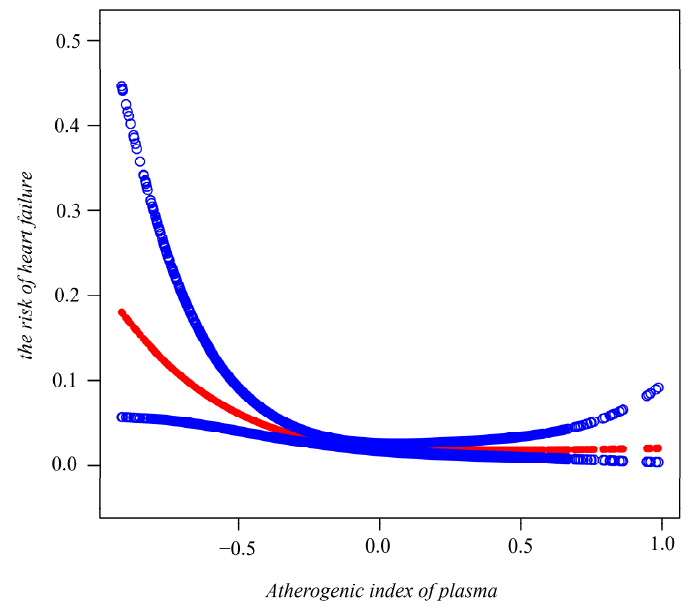
Figure 2. Association between the atherogenic index of plasma and incident heart failure using smooth curve fitting analysis. Adjusted for gender, age, BMI, education level, smoke, coronary heart disease, heart attack, angina, stroke, MetS, diabetes, eGFR, hypertension, glucose, HbA1c, ALT, albumin, globulin, creatinine, blood urea nitrogen, HDL cholesterol, hs-CRP, statins use, diabetes medication, and antihypertensive medication. The red and blue lines demonstrate the estimated values and their corresponding 95% CIs, respectively.